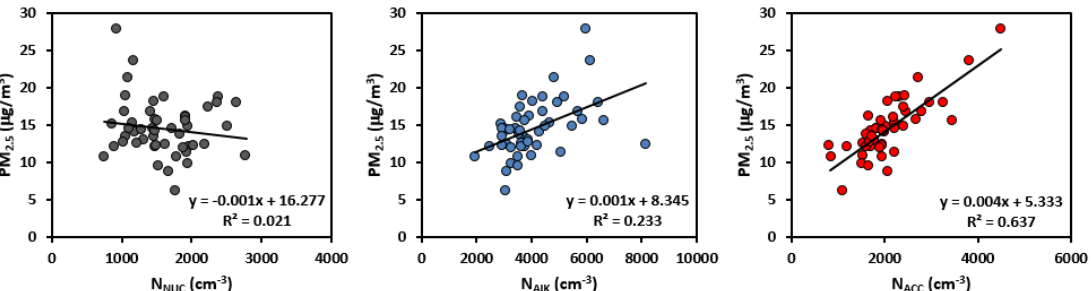
Figure 7. Correlation of monthly average PM 2.5 concentration with particle number concentrations in the different size ranges (from left to right N NUC , N AIK , and N ACC ). The graphs include a linear fit.